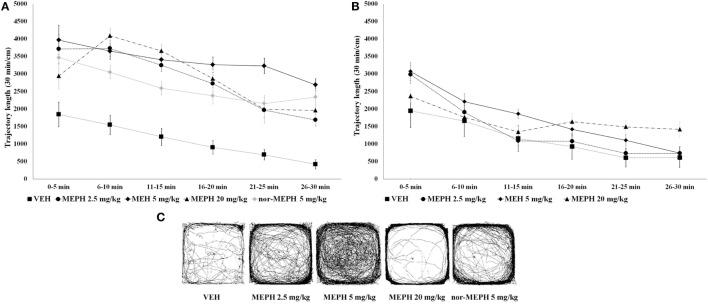
Open field test (OFT): mean trajectory length (divided into 5-min blocks) by testing-onsets [5 and 40 min; (A) and (B), respectively] and drug treatments [vehicle controls (VEH), mephedrone (MEPH) 2.5, 5, and 20 mg/kg and nor-mephedrone (nor-MEPH 5 mg/kg)]. Compared to VEH, significant hyperactivity (p < 0.001 for all drug groups and in all time blocks) was present at the 5-min testing-onset (A), however the treatment effects were no longer significant at the 40 min testing-onset (B). Error bars display ±1 SEM. Picture inserts below (C) show typical trajectory patterns induced by the treatment in animals with 5-min testing-onset.